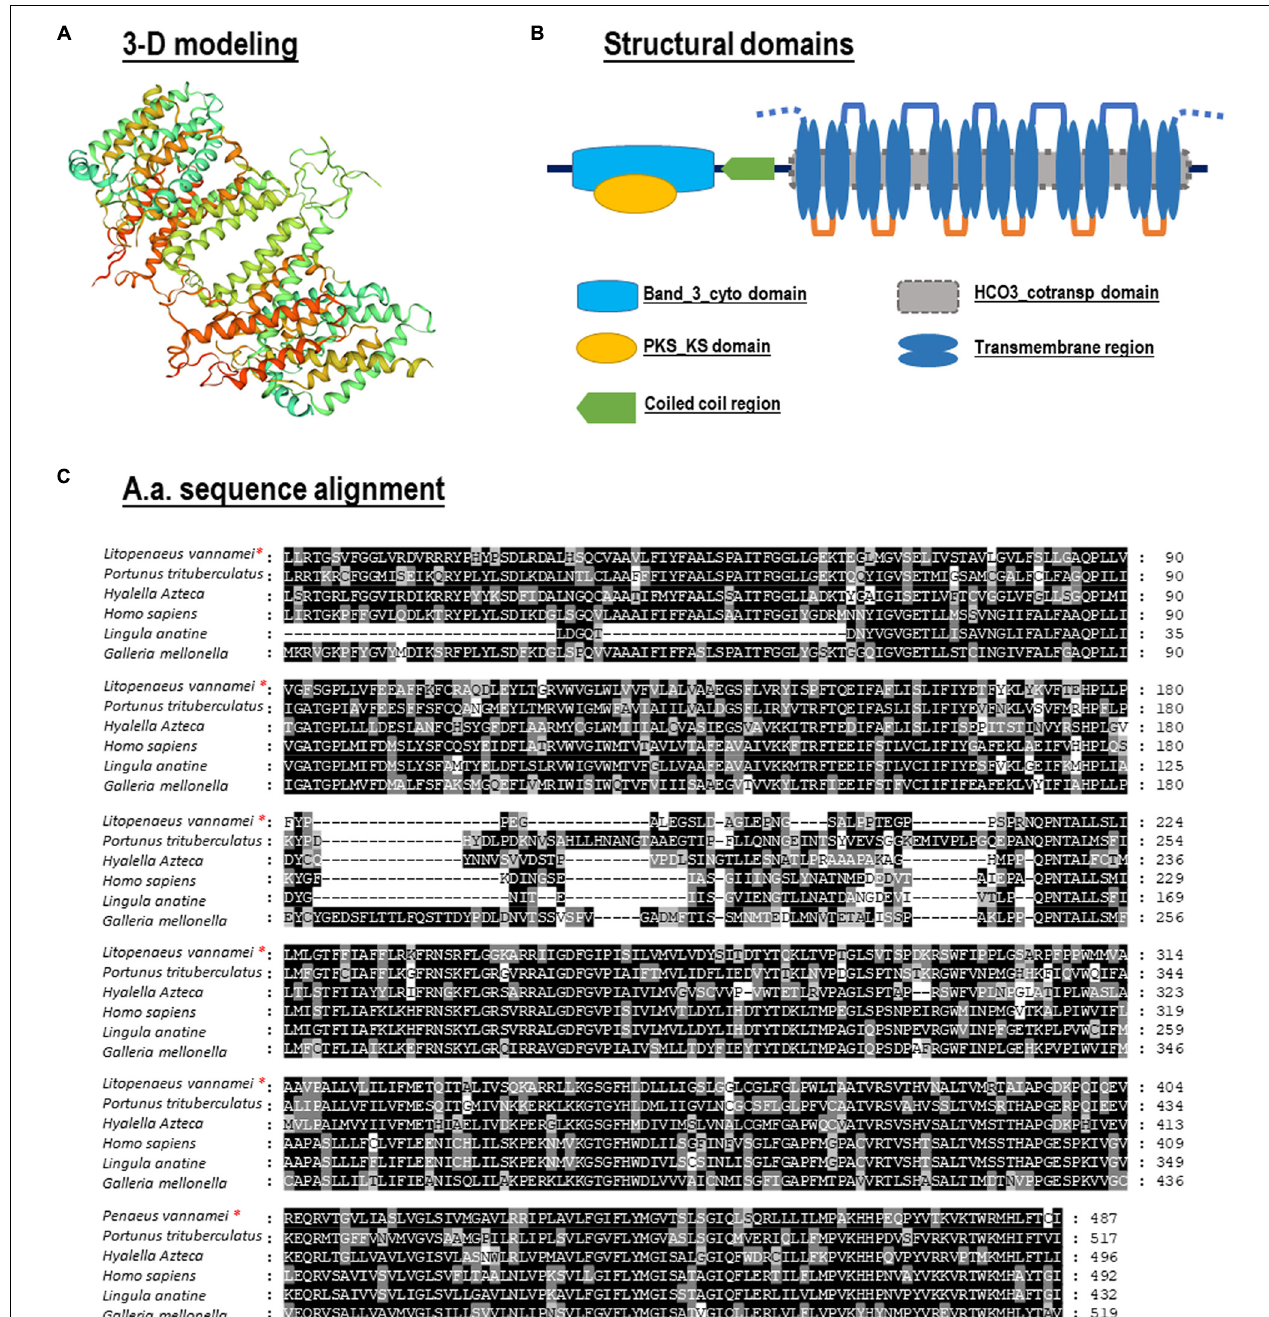
FIGURE 2 | (A) Three-dimensional (3-D) protein model for Lv- AE3 dimer by SWISS-MODEL server; (B) Structural domain of Lv -AE3 predicted by SMART program. (C) Amino acid sequences alignment of AE3s in multiple